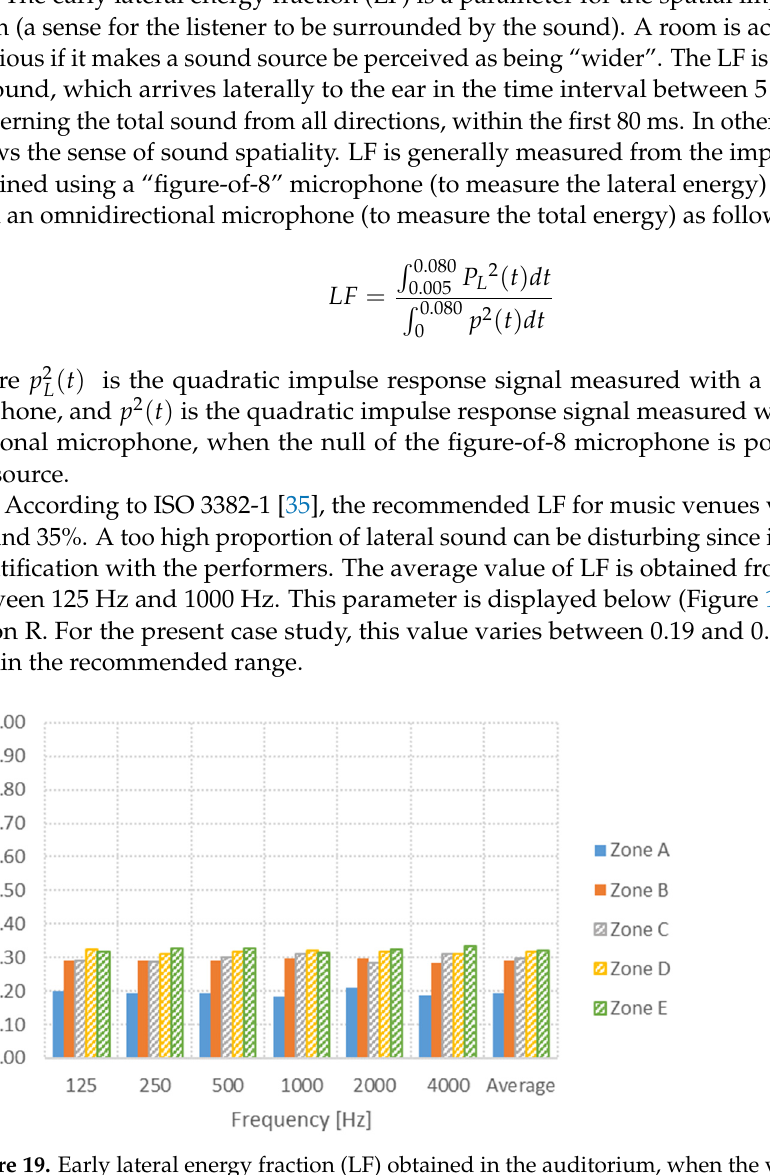
Figure 19. Early lateral energy fraction (LF) obtained in the auditorium, when the variable acoustic solution provides minimum absorption (configuration R), by zones.